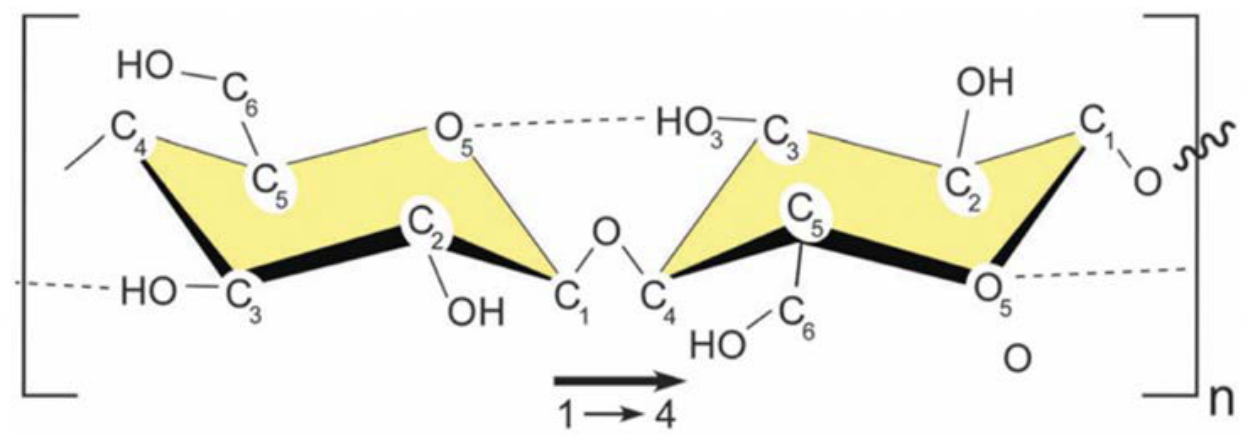
Figure 1. Schematic illustration of cellulose molecule, reprinted with permission from [26], 2011, RSC. The large number of -OH groups in the molecular structure of cellulose make it easy to form intramolecular and intermolecular hydrogen bonds, leading to the aggregation of cellulose molecular chains and the formation of crystalline supramolecular structure. The supramolecular structure of cellulose is divided into crystalline and amorphous regions [28]. In the crystalline region, many intermolecular hydrogen bonds exist, and the molecular chains are orderly packed. However, molecular interaction is weaker in the amorphous region than in the crystalline region, and the molecular chain arrangement is disordered with a loose structure. The XRD analysis of the crystalline structure of cellulose shows that the intensity of the X-ray diffraction peak in the crystalline region is high, while no specific diffraction peak is observed in the amorphous region